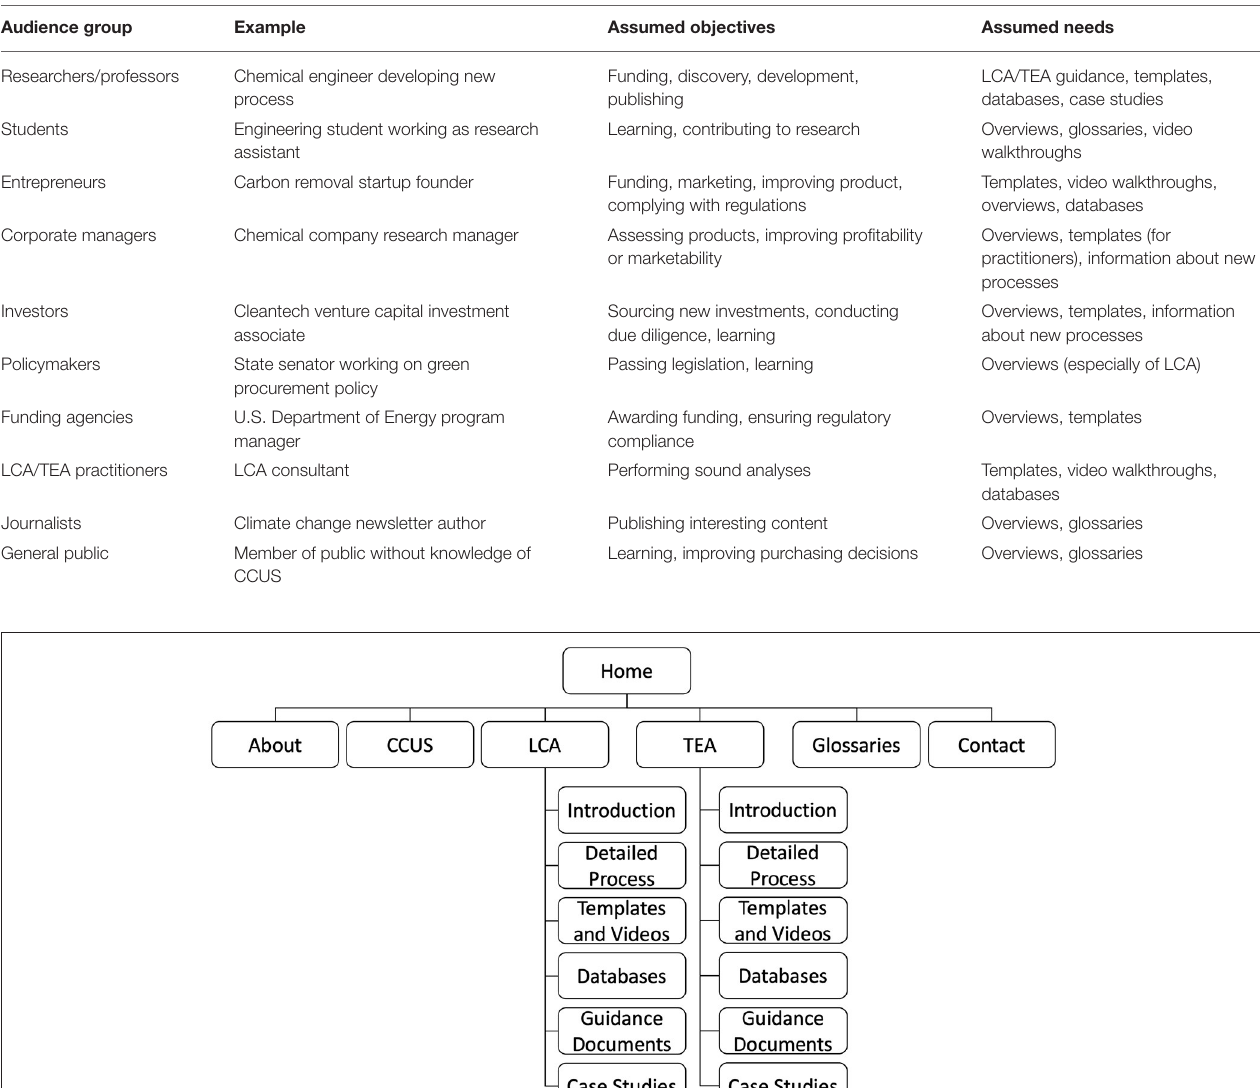
TABLE 1 | Results of audience needs mapping.